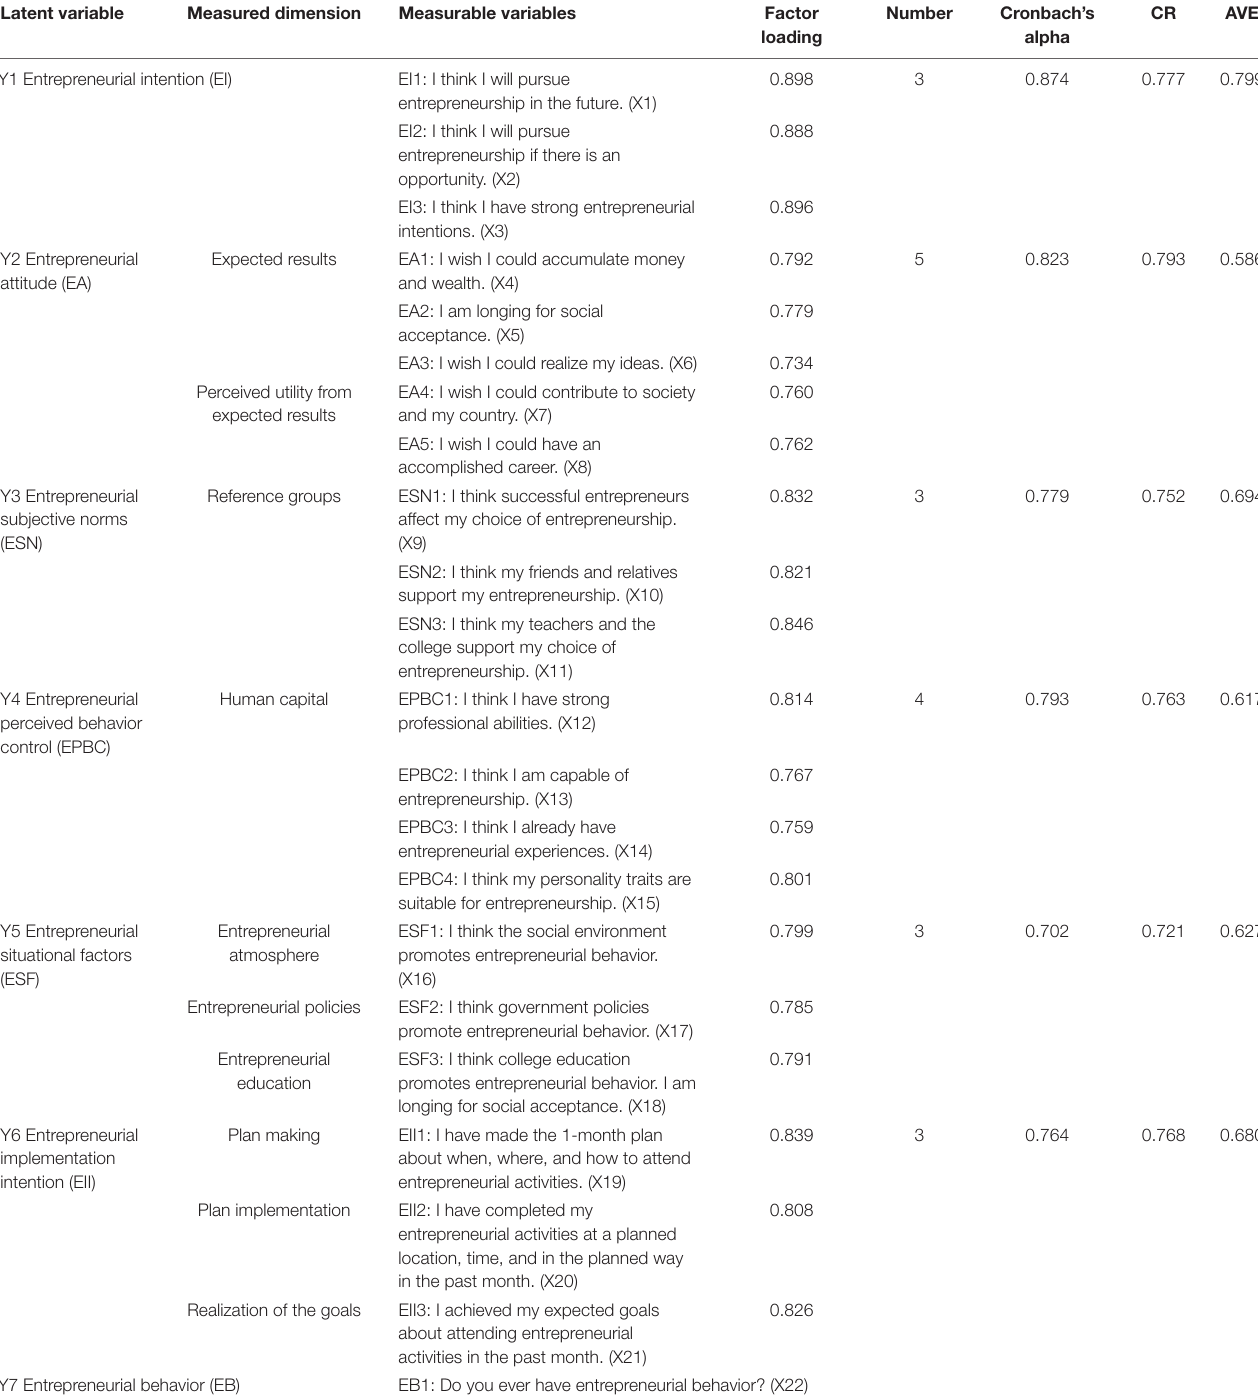
TABLE 3 | Factor analysis, reliability and validity